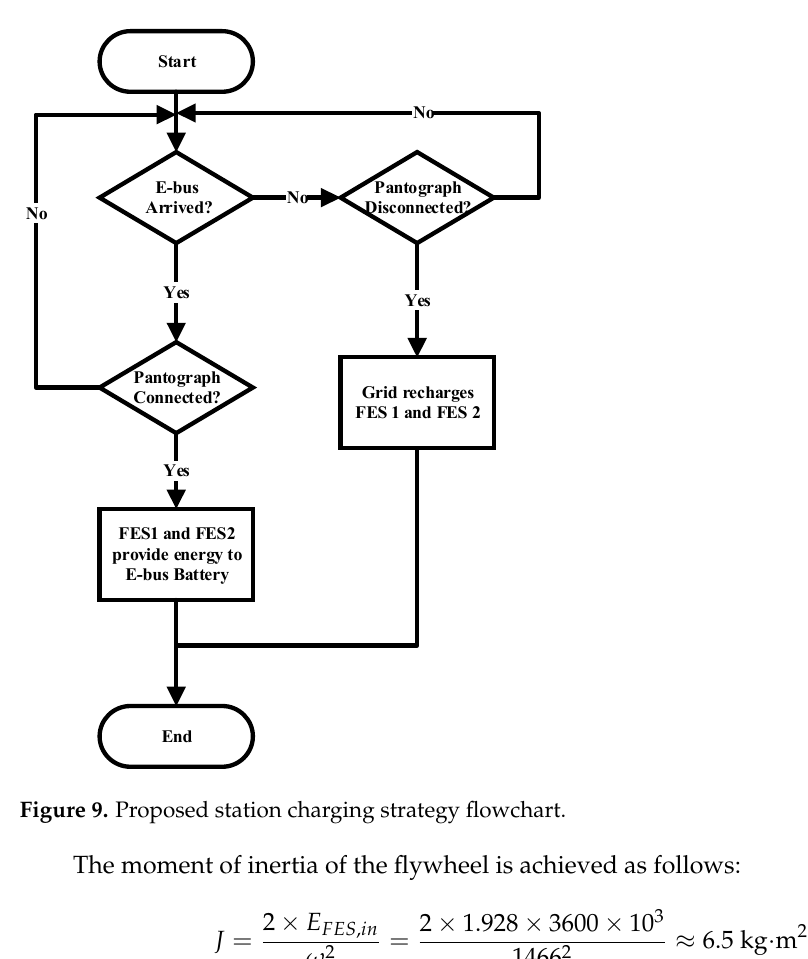
Figure 8. Proposed E-bus flash charging structure.